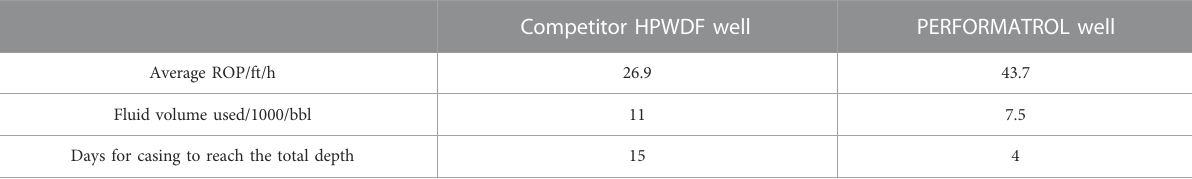
TABLE 4 Performance comparison between PERFORMATROL and another HPWDF used in the Middle